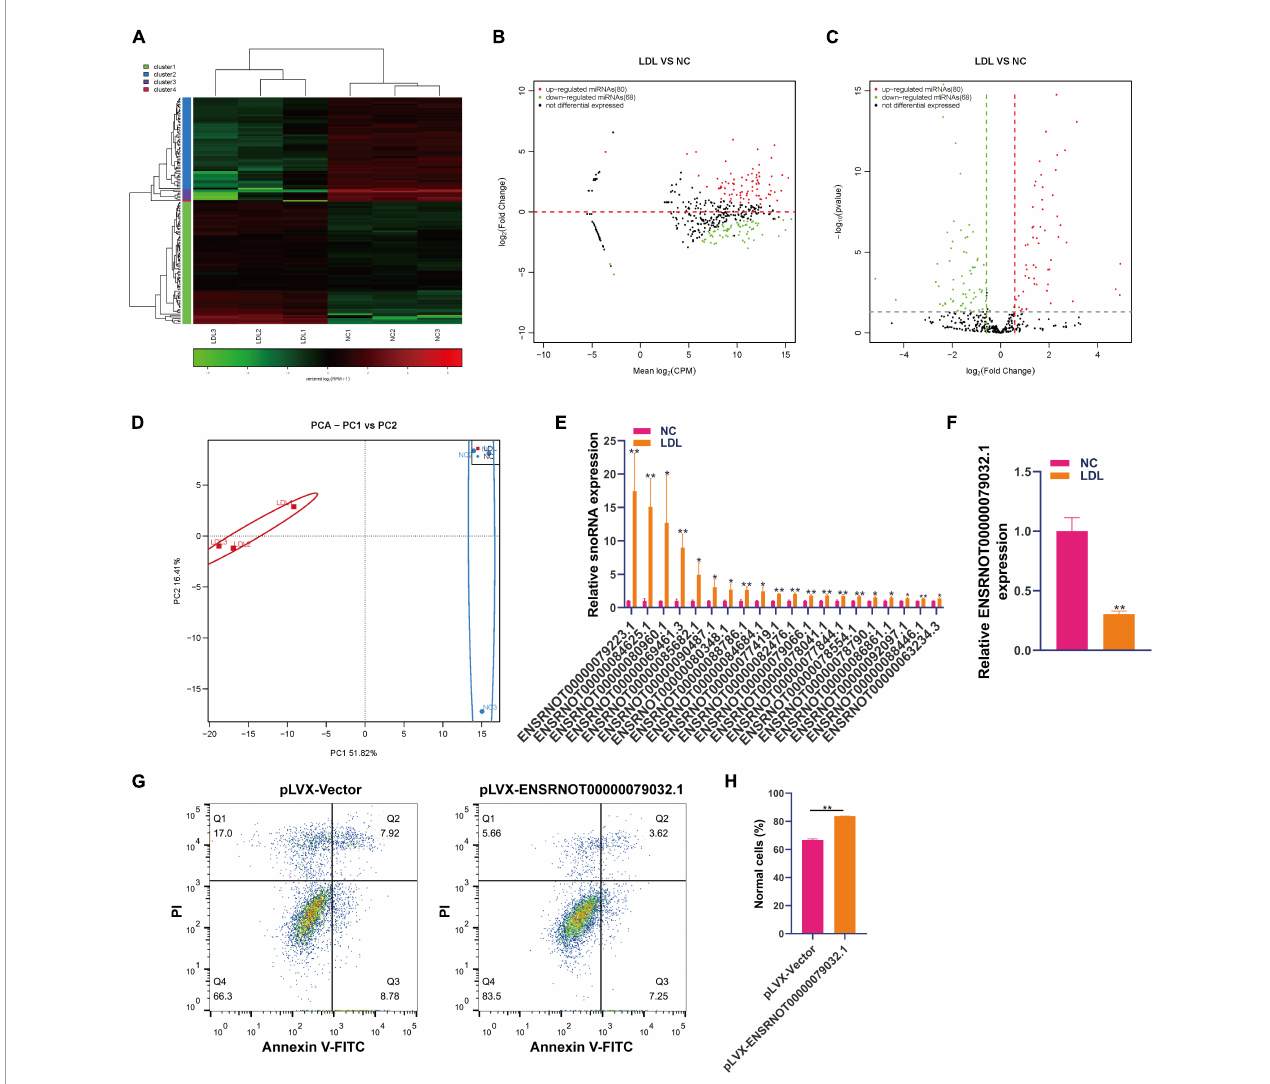
FIGURE2 Differential expression of snoRNA in rat endothelial cells treated with ox-LDL. Heatmap (A) , MA map (B) , and volcano map (C) show the expression of snoRNA in rat endothelial cells with ox-LDL treatment, n = 3. (D) PCA showed the expression of snoRNA in rat endothelial cells with or without ox-LDL treatment, n = 3. (E) qPCR detected the expression of snoRNA in rat endothelial cells with or without ox-LDL treatment. (F) qPCR detected the expression of snoRNA in rat endothelial cells with or without ox-LDL treatment. (G) Flow cytometry assay of cell apoptosis after treatment